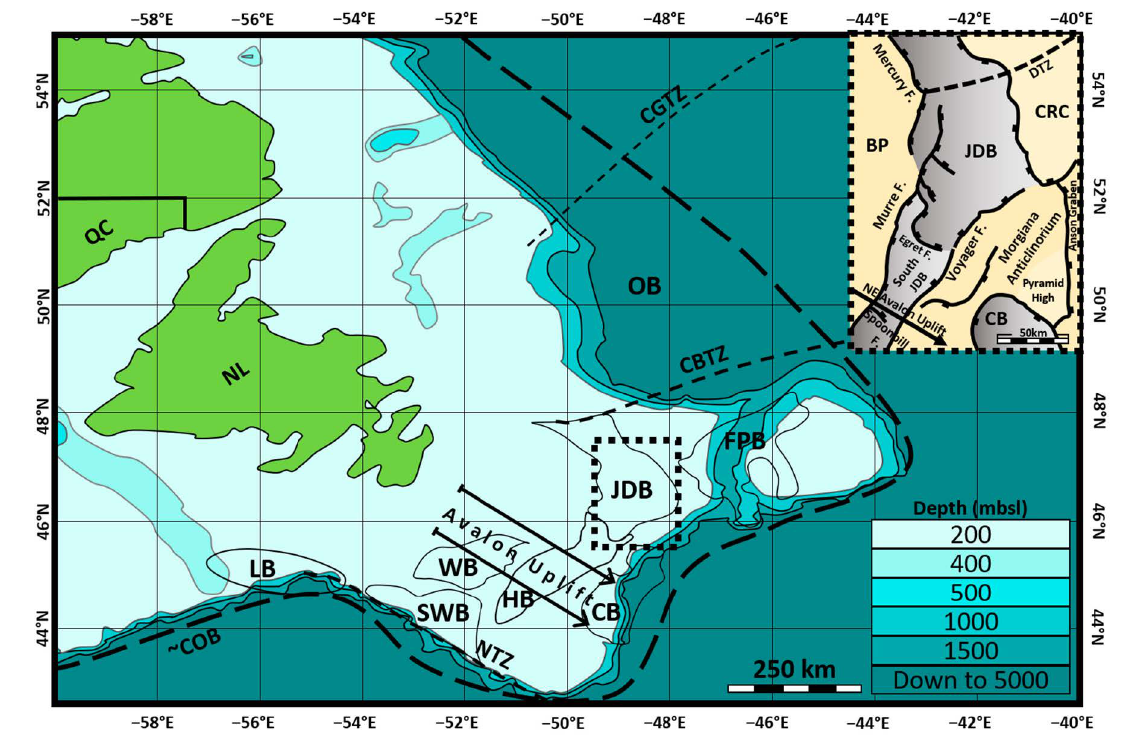
Figure 1. Overview of the Grand Banks of Newfoundland. NTZ = Newfoundland Transfer Zone, CBTZ = Cumberland Belt Trans- ferZone, CGTZ=CharlieGibbsTransferZone, ~COB=Continental-OceaniccrustBoundary(approximate), LB = Laurentian Basin, SW = South Whale Basin, WB = Whale Basin, HB = Horseshoe Basin, CB = Carson Basin, JD = Jeanne d’Arc Basin, FP = Flemish Pass Basin. Dashed square region corresponds to inset. Inset: BP = Bonavista Platform, CRC = Central Ridge Complex, DTZ = Dominion Transfer Zone. Adapted from